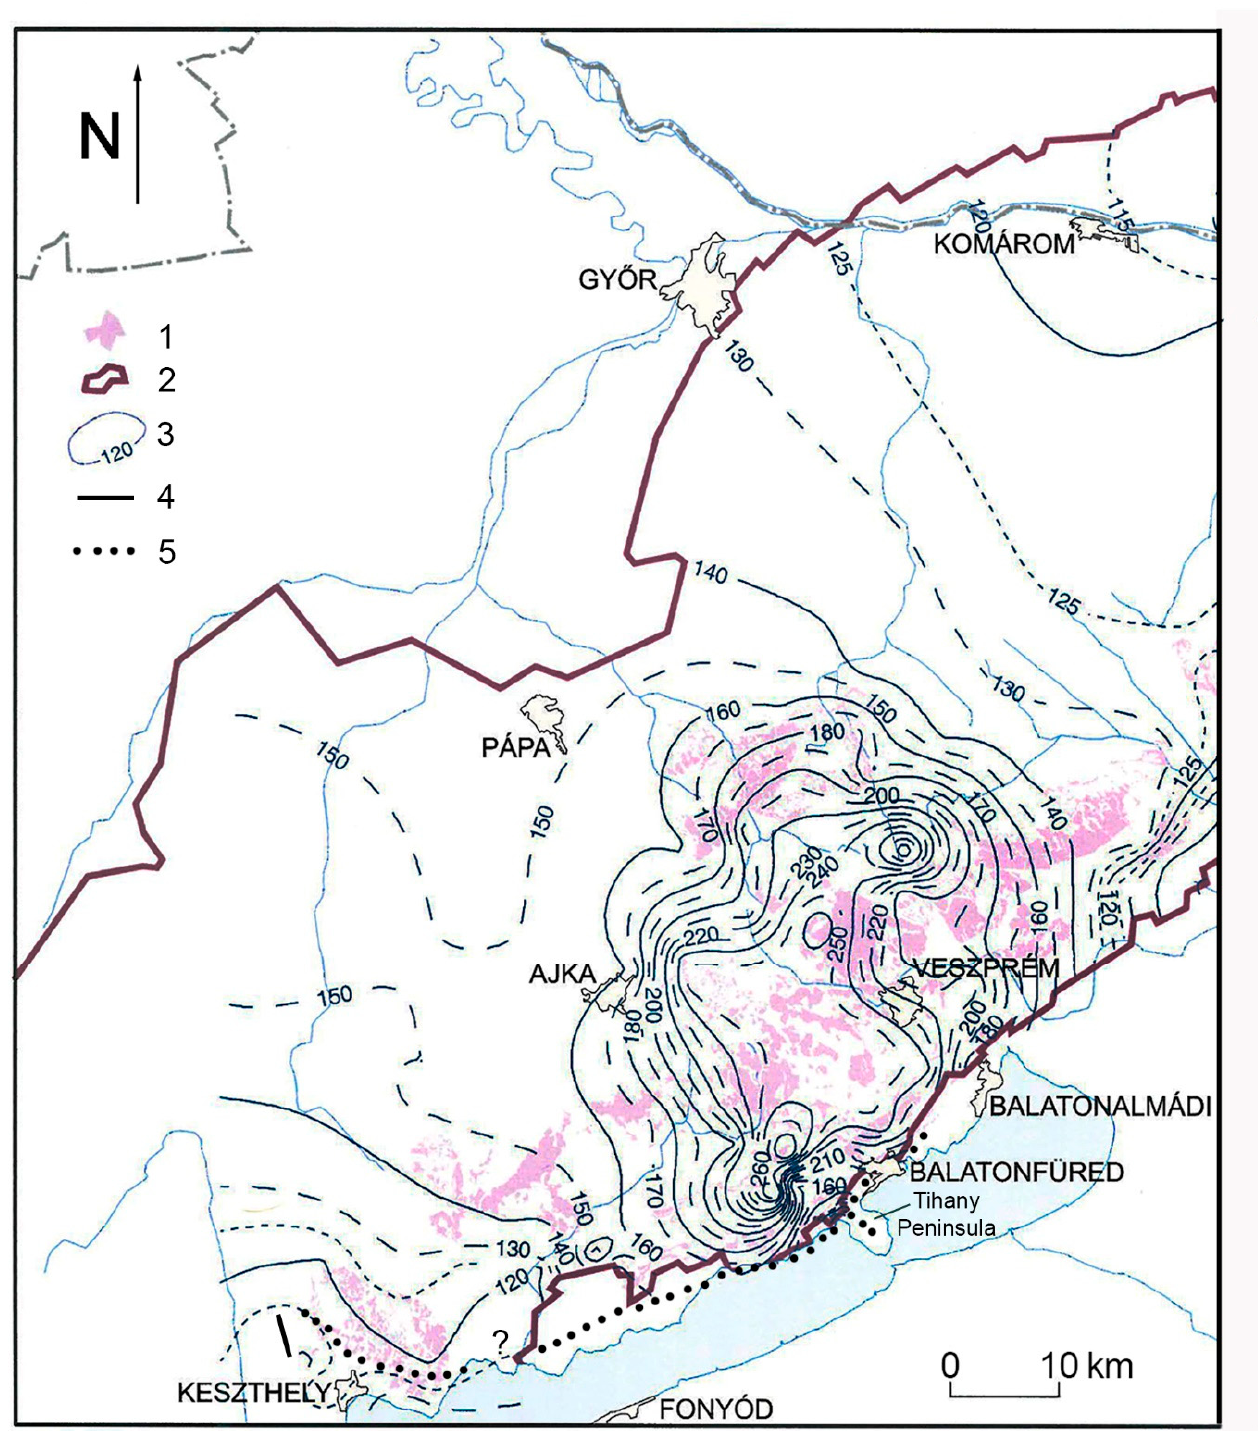
Figure 3. Regional groundwater of the mountains in January 2006 [20] (modified). Legend: 1. Infil- tration area, 2. Boundary of groundwater storage, 3. Altitude of the isoline of groundwater level, 4. Hypogene branch, 5. Former hypogene branch.